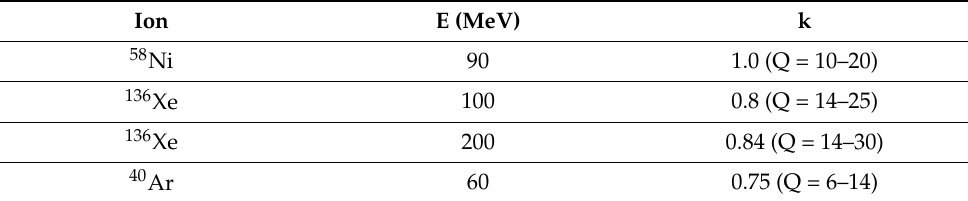
Figure 4. Electronic stopping power (S e ) as a function of the projectile ion charge Q for WO 3 calculated by CasP [55] using the Bragg additive rule for 200 MeV Xe, 100 MeV Xe, 90 MeV Ni and 60 MeV Ar. Power-law fits are also shown for Q = 14 to 30 (200 MeV Xe), Q = 14 to 25 (100 MeV Xe), Q = 10 to 20 (90 MeV Ni) and Q = 6 to 14 (60 MeV Ar). Table 4. Ion, energy (E in MeV), exponent (k) of power-law fit that the charge(Q)-dependent electronic stopping power S e is proportional to Q k for WO 3 . S e is calculated by CasP [55]. The region of the charge for the power-law fit is given in